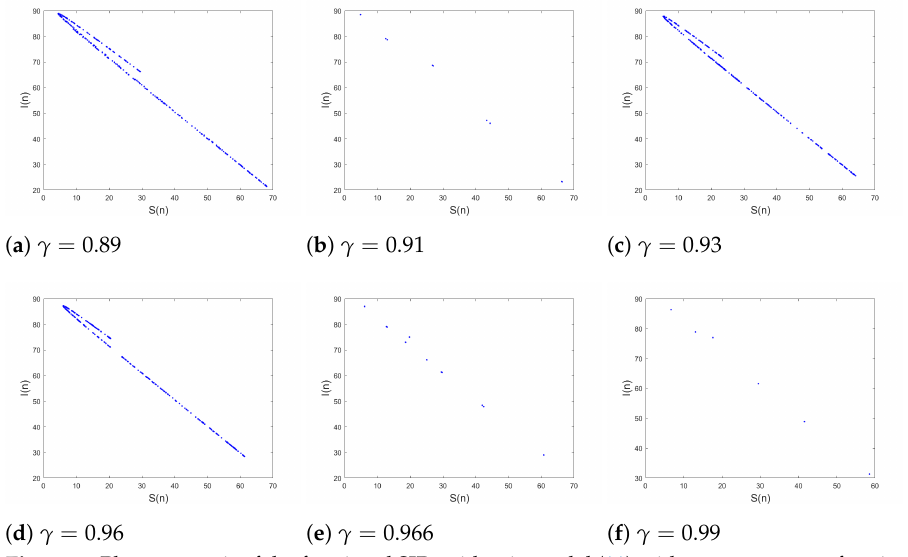
Figure 5. Phase portrait of the fractional SIR epidemic model (11) with commensurate fractional-order values for N = 100, β = 0.8, σ = 0.1, p = 0.005, and initial conditions ( S ( 0 ) , I ( 0 )) = ( 70,30 )